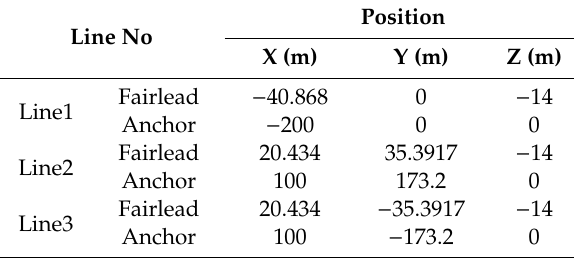
Table 6. Mooring line position.